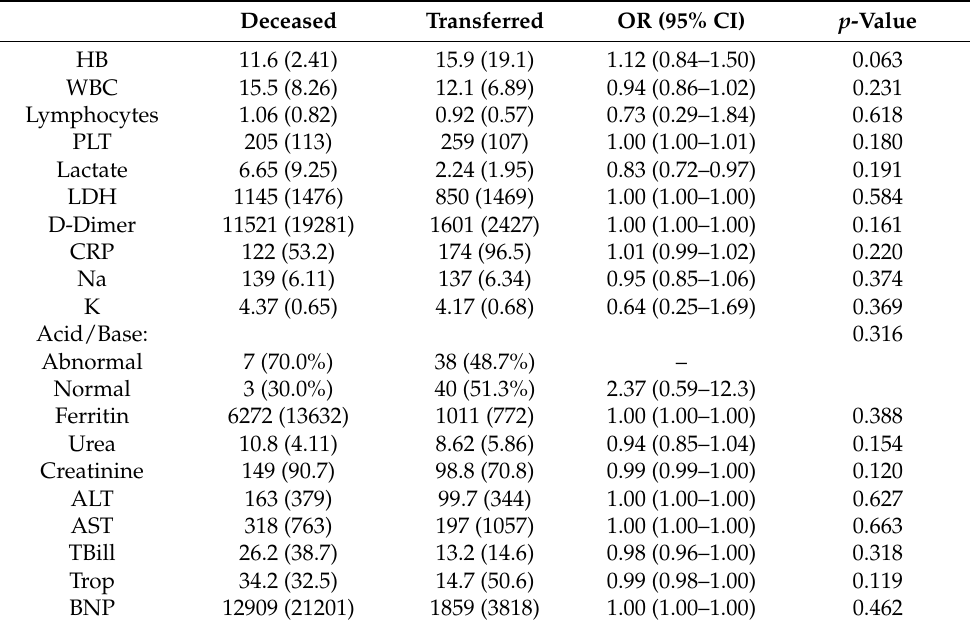
Table 3. Laboratory data of deceased and transferred COVID-19 ICU